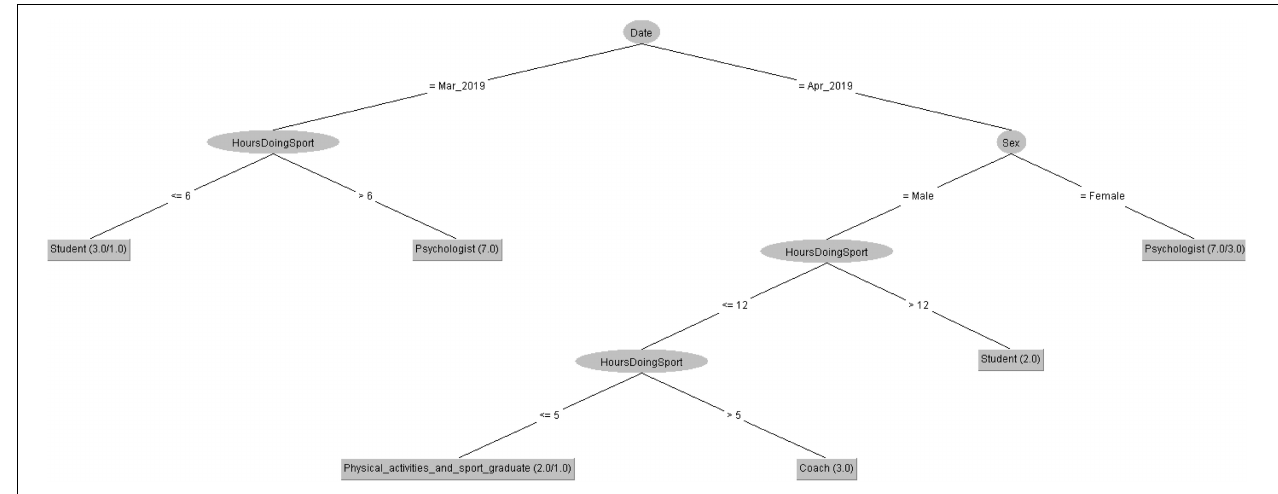
FIGURE 9 | Profession of people taking the POMS questionnaire in 2019 decision